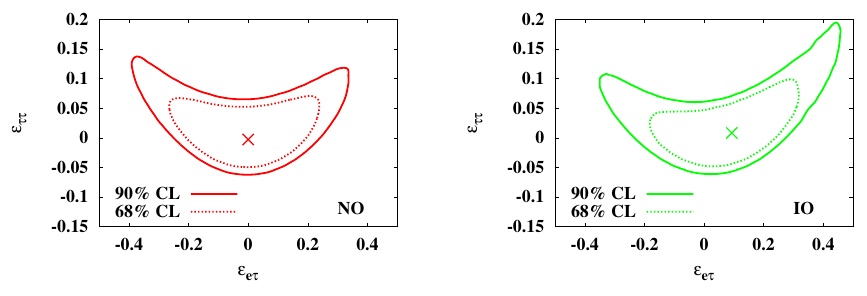
Figure 7 . The same as in (cid:12)gure 6 but for (cid:15) ee = 0 : 2.